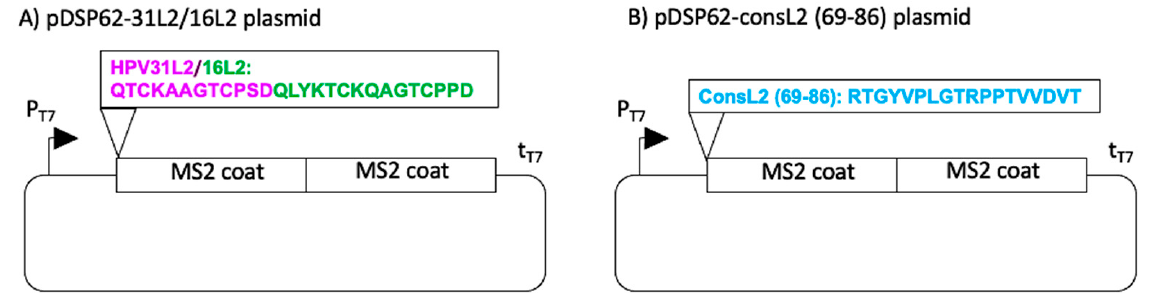
Figure 1. Plasmids with L2 sequences that were used for protein expression. 31L2/16L2 sequence ( A ) and consL2 (69-86) sequence ( B ) were inserted into plasmid by polymerase chain reaction in a previous study [15].